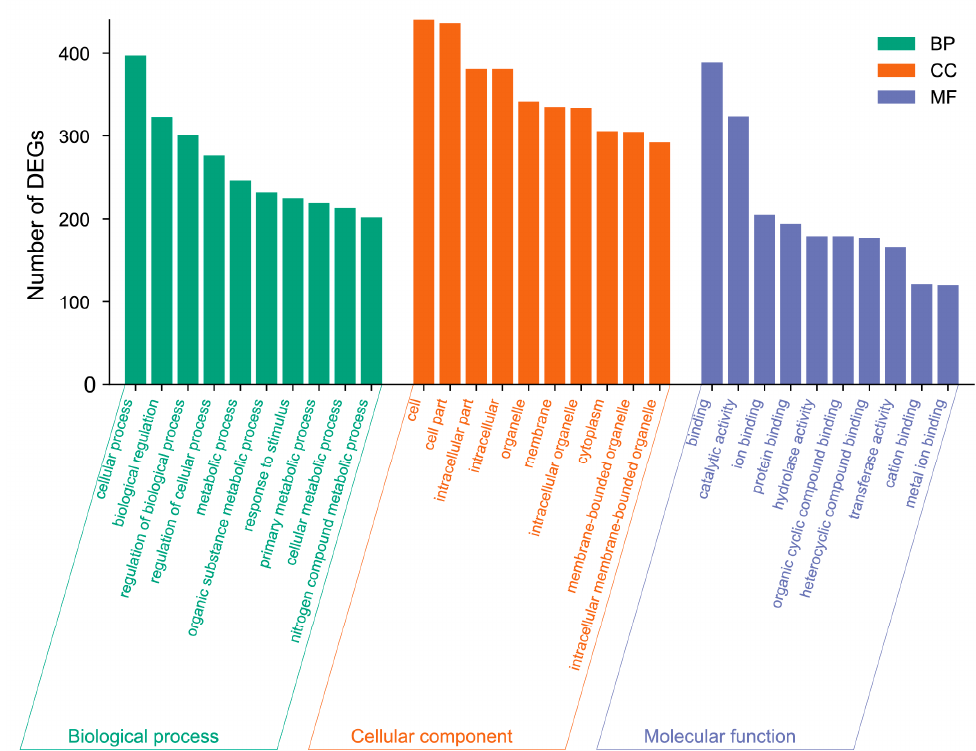
Figure 2. GO enrichment analyses of the DEGs in livers of Hu sheep and Tibetan sheep. The GO terms include biological processes (BPs), cellular components (CCs), and molecular functions (MFs).